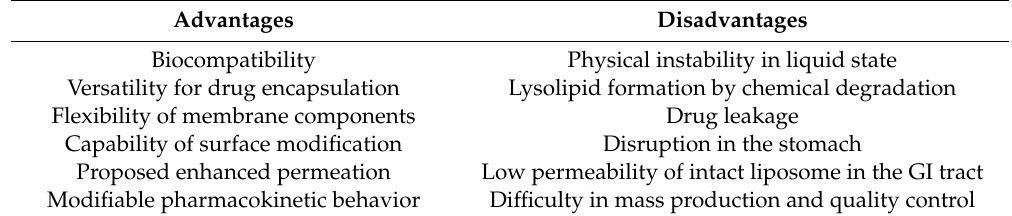
Table 3. Advantages and disadvantages of liposomes as an oral delivery